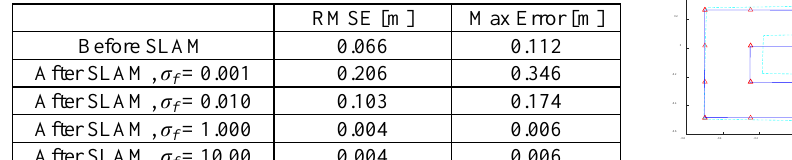
Figure 4: Estimated trajectory using GP-SLAM with the wrong l . (Top Left) l = 0.005m, (Top Right) l = 0.050m, (Bottom Left) l = 0.150m, and (Bottom Right) l = 0.400m. The cyan dash line shows the odometry only solution, the blue solid line